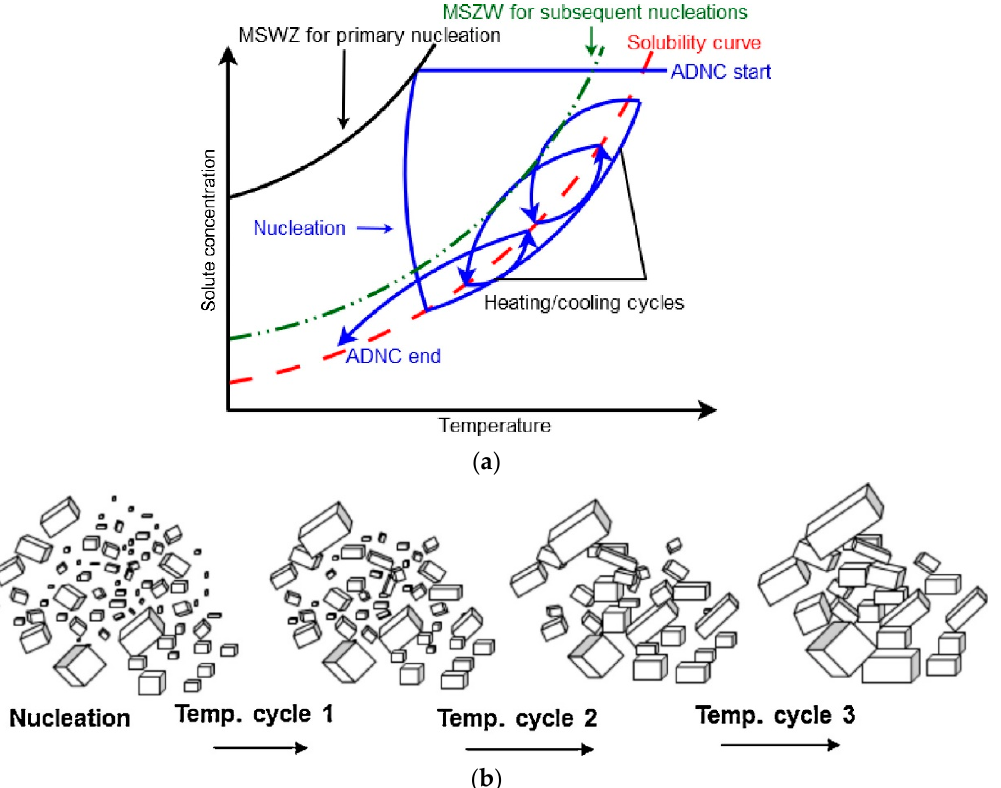
Figure 14. Schematic working of the automated direct nucleation control (ADNC) approach ( a ); Effect of temperature cycling on a crystal suspension ( b ). (Caption and figure reprinted with permission from Reference [35]).